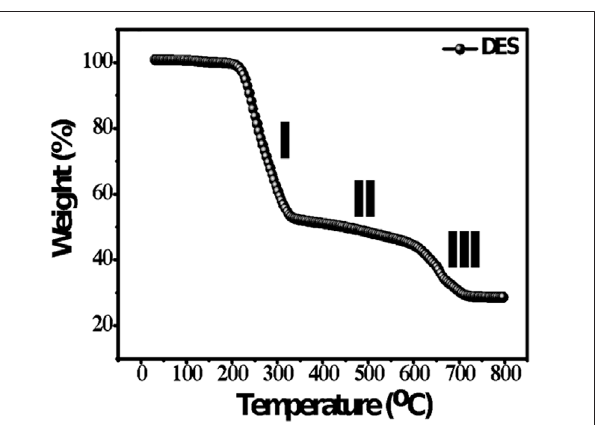
FIGURE 4 | TGA analysis of the ZE electrolyte in N 2 atmosphere at a heating rate of 5 ° C min − 1 .